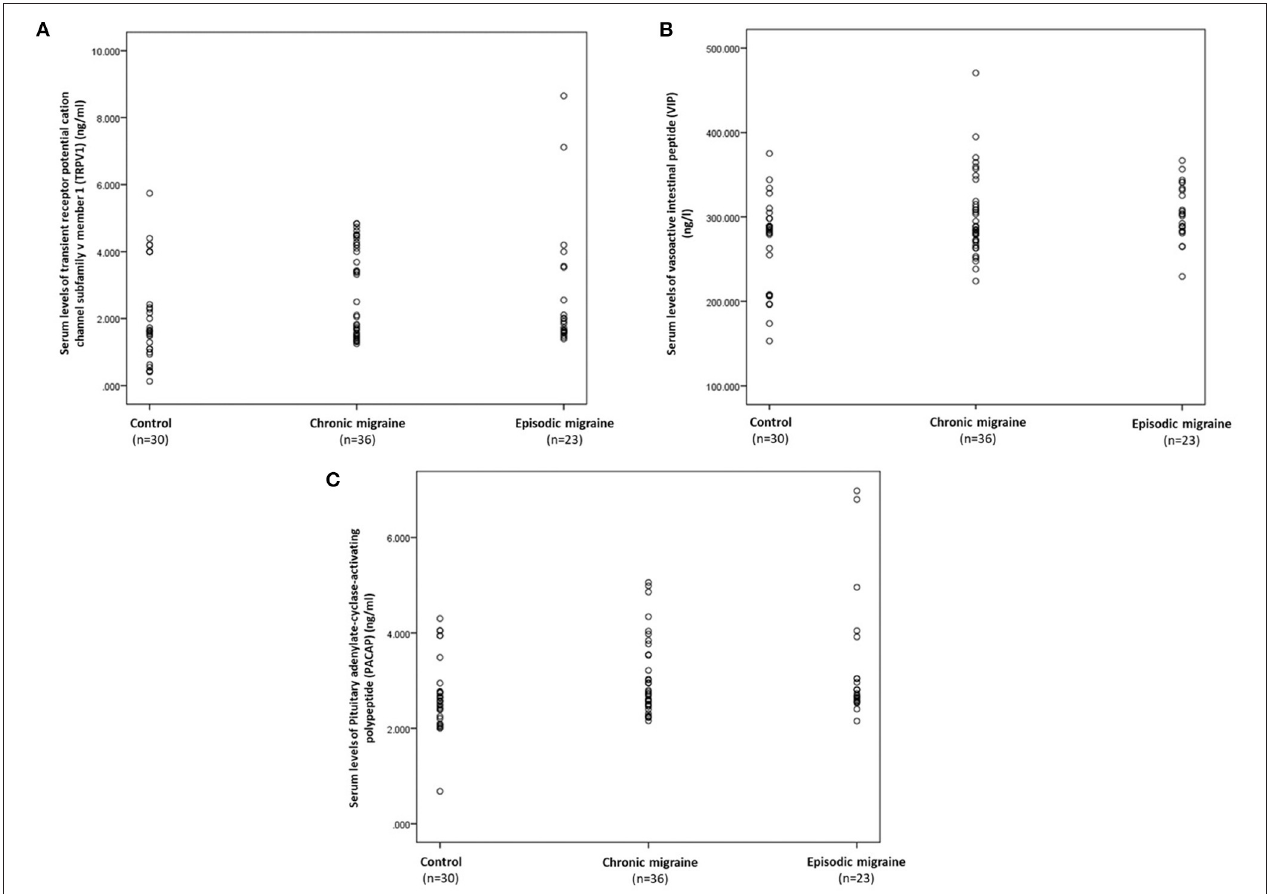
FIGURE 1 | Scatter plots displaying the individual’s distribution of serum concentrations of TRPV1 (A) , VIP (B) , and PACAP (C) according to the control, chronic, and EM groups. TRPV1, transient receptor potential vanilloid type-1 receptor; VIP, vasoactive intestinal polypeptide; PACAP, pituitary adenylate cyclase-activating